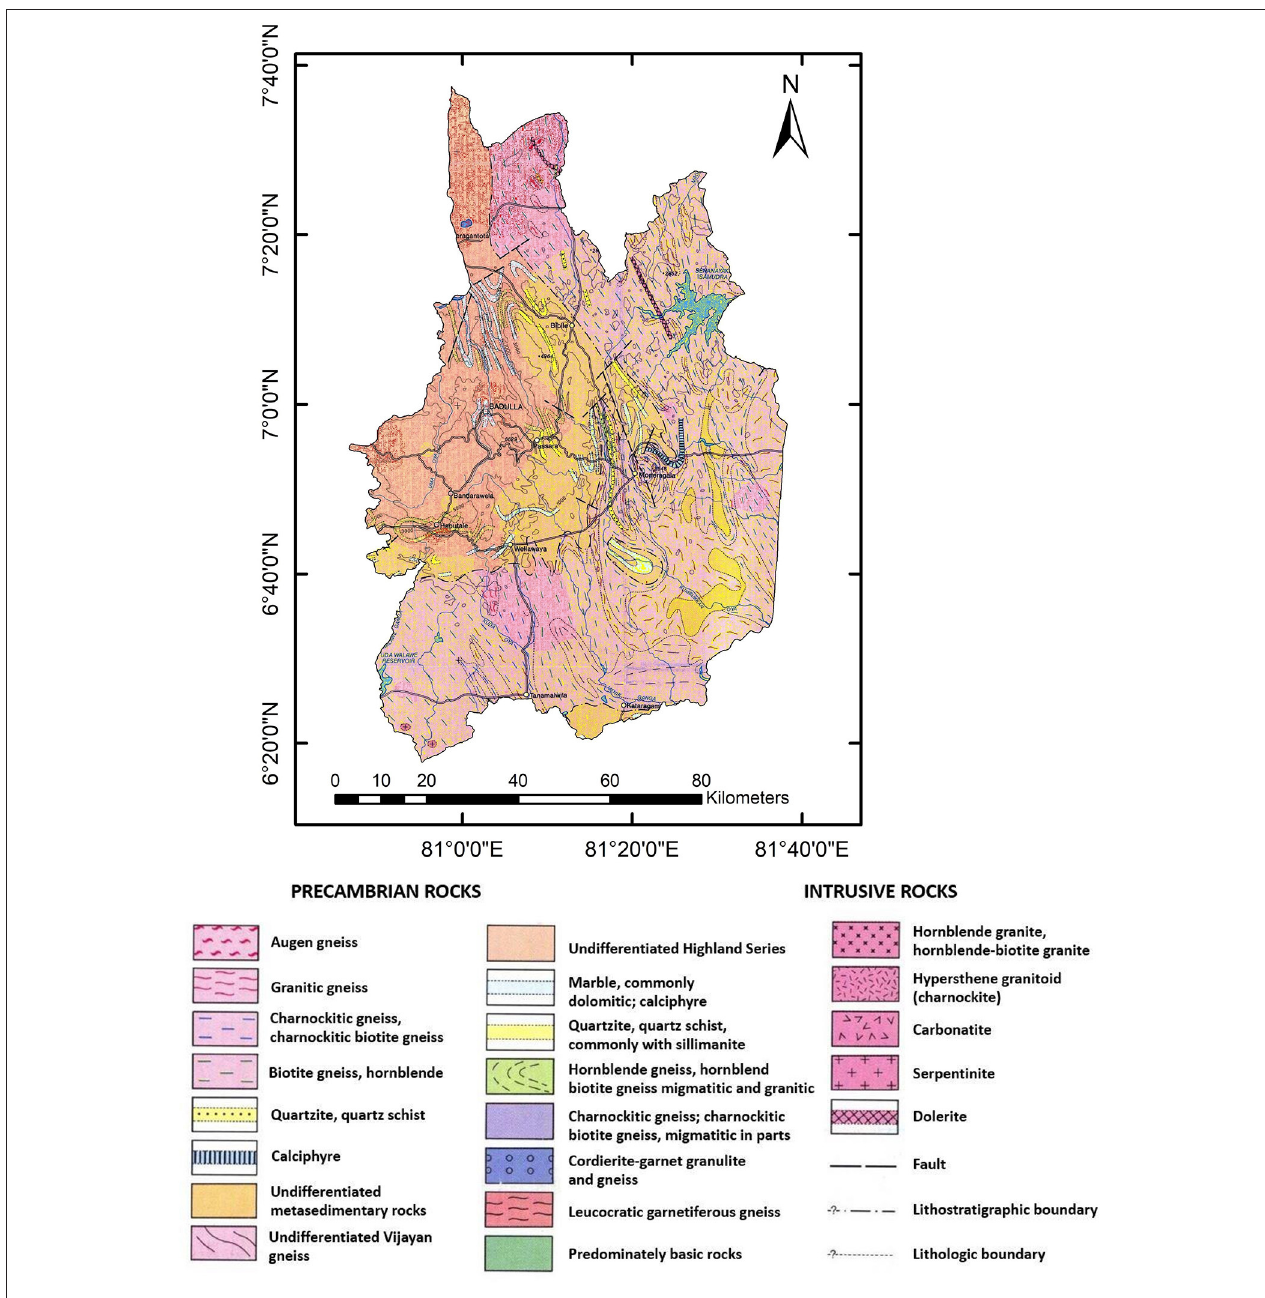
FIGURE 2 | Geology map of the Uva Province (Cooray,